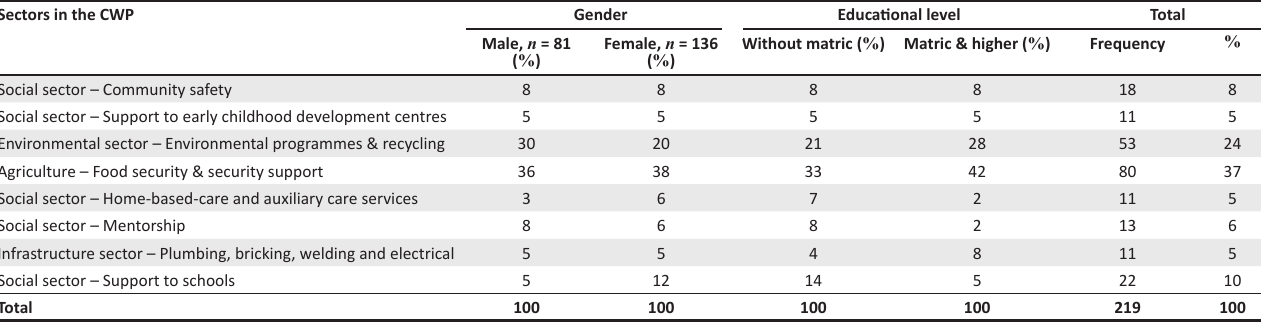
TABLE 3: Respondents’ community work programme sectoral participation; by gender and qualification. Sectors in the CWP